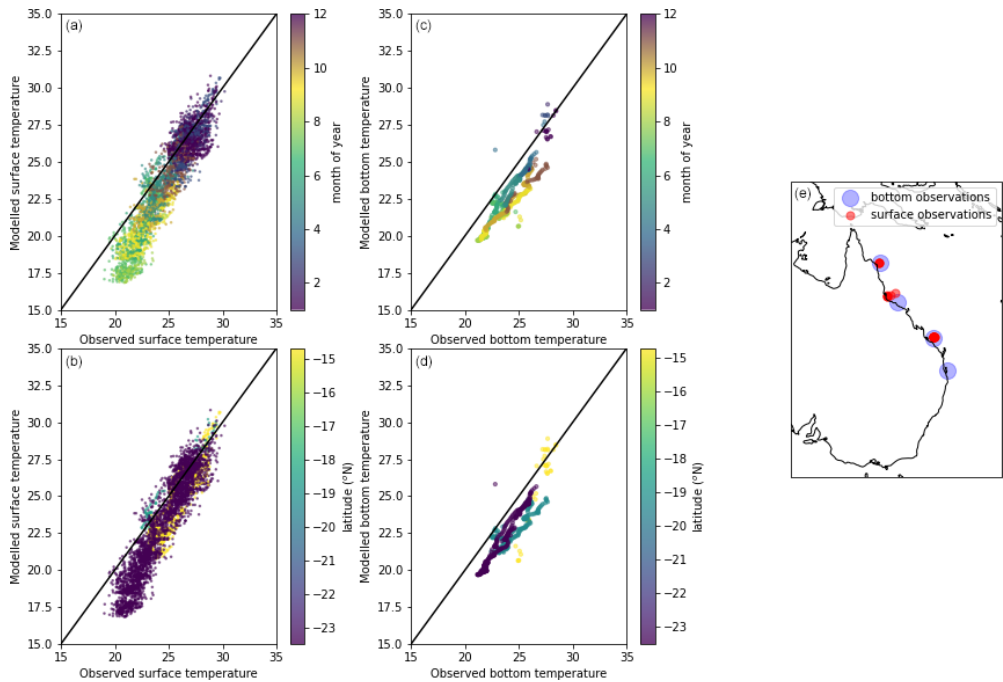
Figure 17. Comparison of S2P3R v2.0 surface (a, b) and bottom (c, d) temperatures against mooring observations from IMOS and FAIMMS and moorings (Integrated Marine Observing System; IMOS). Facility for the Automated Intelligent Monitoring of Marine Systems – FAIMMS; GBRHIS: Heron Island South Shelf mooring component of the GBR mooring array; GBRLSH: Lizard Island Shelf mooring component of the GBR mooring array; GBRPPS: Palm Passage Shelf mooring component of the GBR mooring array; Northern Australia Automated Marine Weather and Oceanographic Stations, sites: Yongala mooring (NRSYON); GBROTE: One Tree Island Shelf mooring component of the GBR mooring array; IMOS – ANMN National Reference Station (NRS) Ningaloo mooring (NRSNIN). The x − y values of the data presented in plots on the top and bottom ( a and b , and c and d ) are identical but are coloured to highlight where temporal and geographical biases exist in the model output. Seabed observations are considered here to be those falling within 5m of the site depth for each mooring. The map shows the location of surface (red) and bottom (blue) temperature mooring observations used in model evaluation over the GBR.